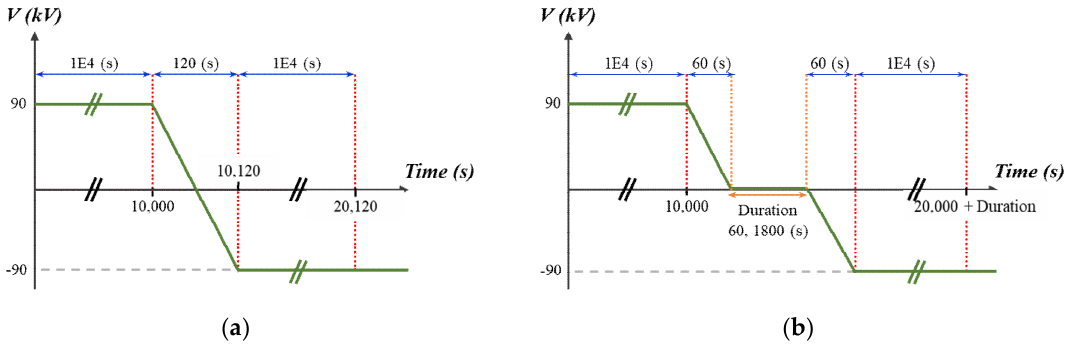
Figure 3. Applied polarity reversal voltage waveforms: ( a ) Without electric potential zero duration; ( b ) with electric potential zero duration.